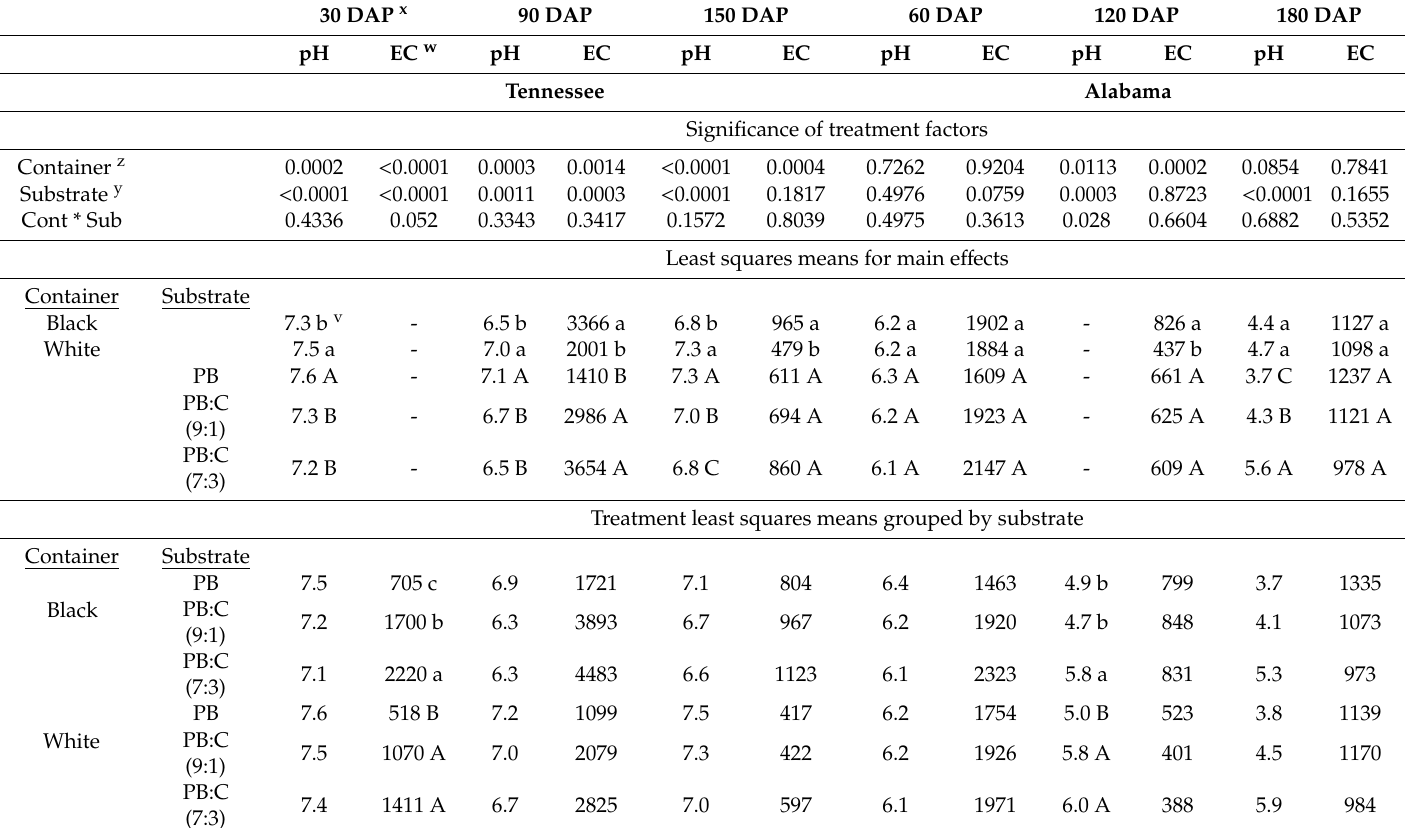
Table 2. Substrate pH and electrical conductivity ( n = 4) of “Green Giant” arborvitae grown in di ff erent types of containers and substrates in Tennessee (McMinnville) and Alabama